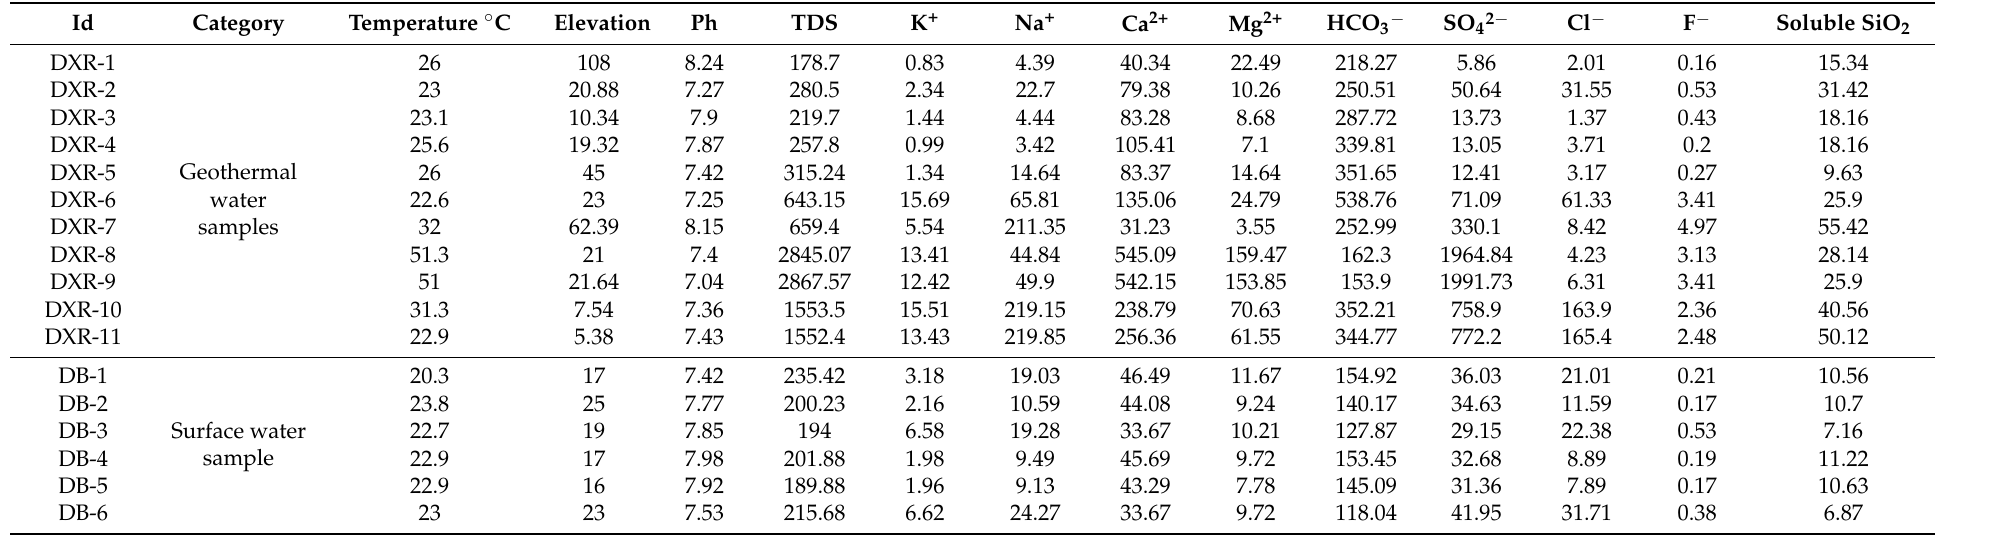
Table A1. Field indicators and water chemical composition units of geothermal water samples